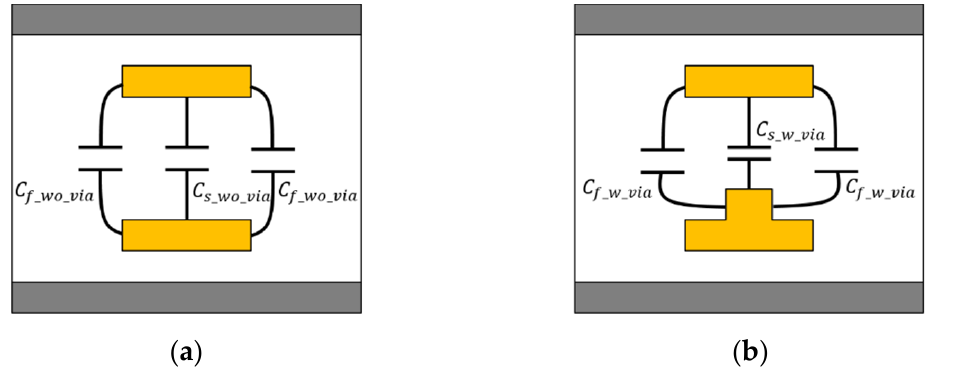
Figure 4. Modeling of mutual capacitance of the proposed channel structure. ( a ) Section A: without the vertical tabbed via, ( b ) Section B: with the vertical tabbed via.